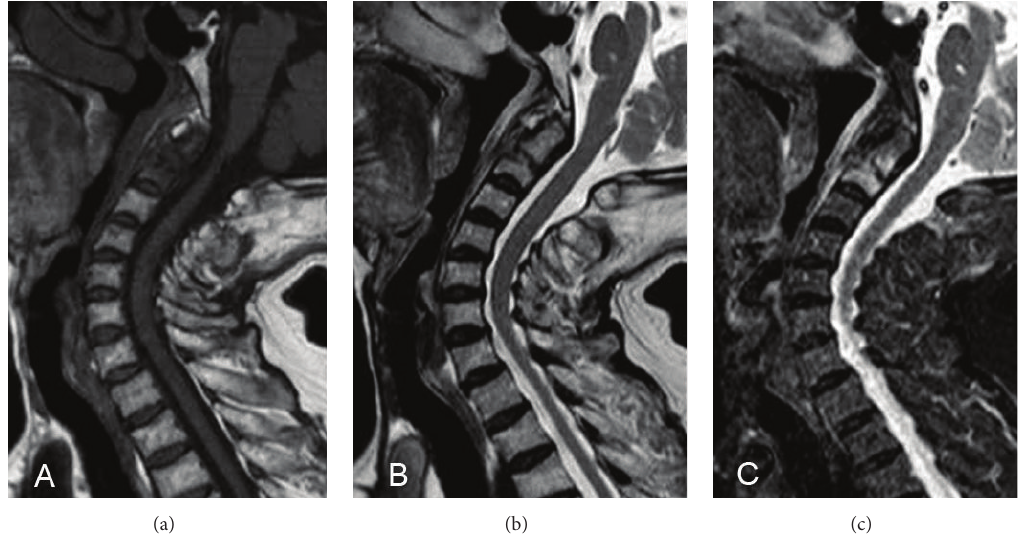
Figure 2: Magnetic resonance imaging demonstrated overt intensity changes of C2, which was low intensity on both (a) T1- and (b) T2- weighted images but high intensity on STIR (c) images. Spinal cord involvement was not